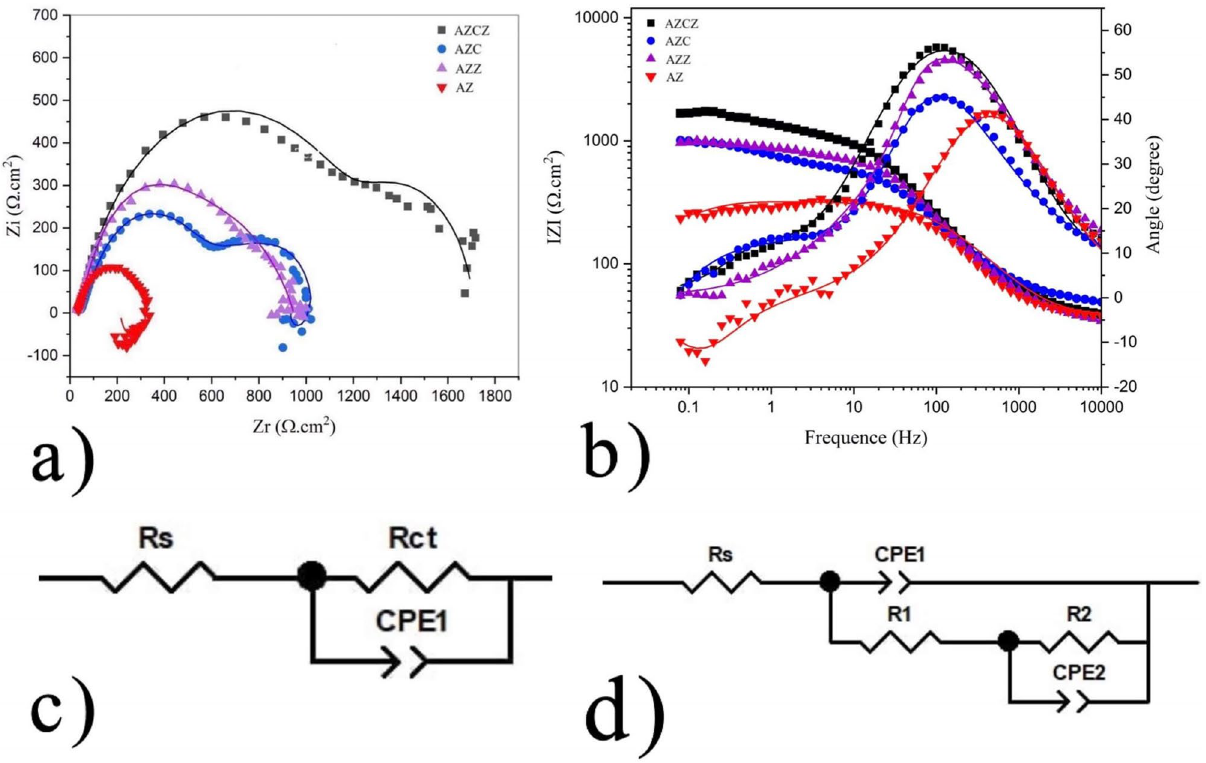
Figure 5. Electrochemical impedance spectroscopy of the biodegradation process of AZ91 in SBF. Effect of surface modification by chitosan and chitosan-MOF films on the ( a ) Nyquist and ( b ) Bode plots. The simulated equivalent circuits for ( c ) bare and chitosan/MOF modified alloy, and ( d ) chitosan-modified specimen. The fitting parameters are reported in Table 5.